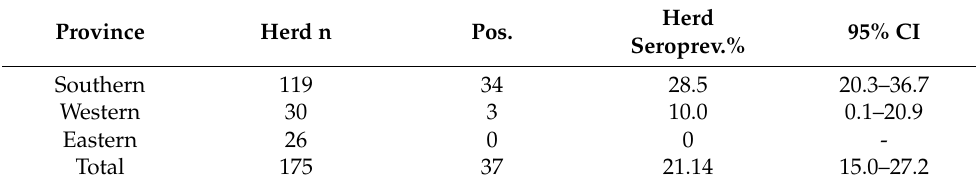
Table 3. Herd-level brucellosis seroprevalence by province.